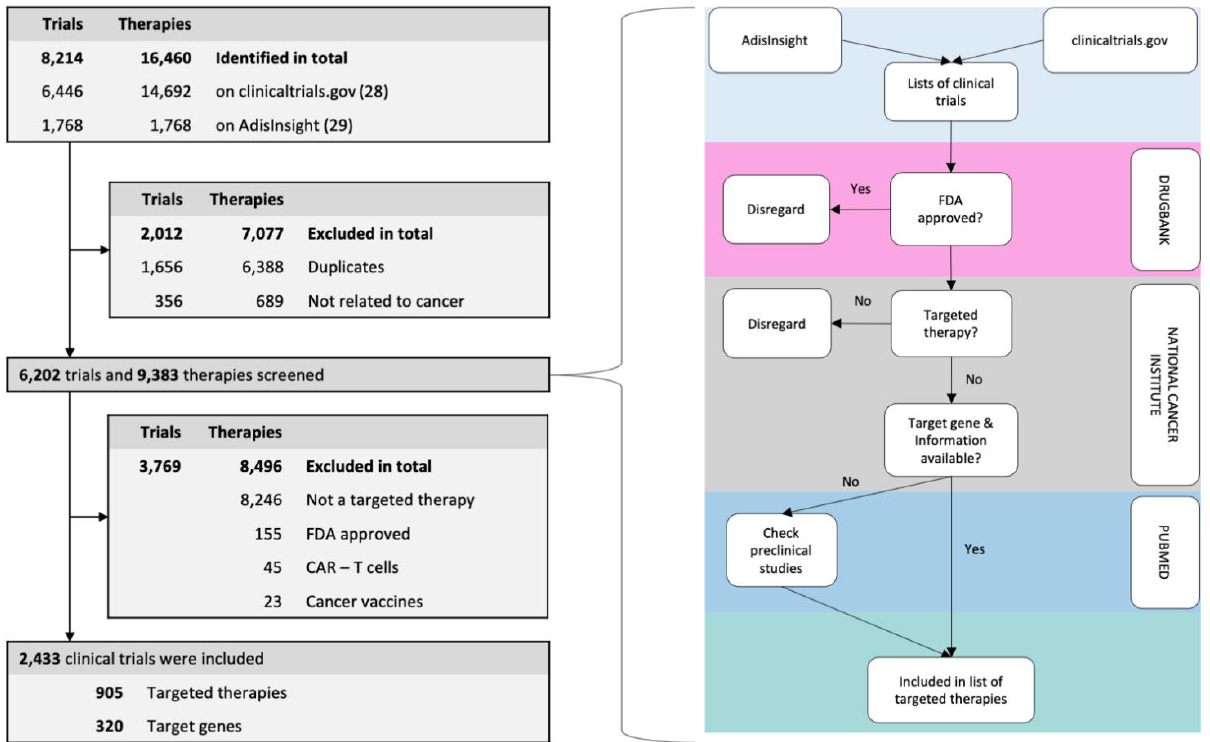
Figure 1. Flow diagram of methodological proceed acquiring non-FDA-approved drugs.